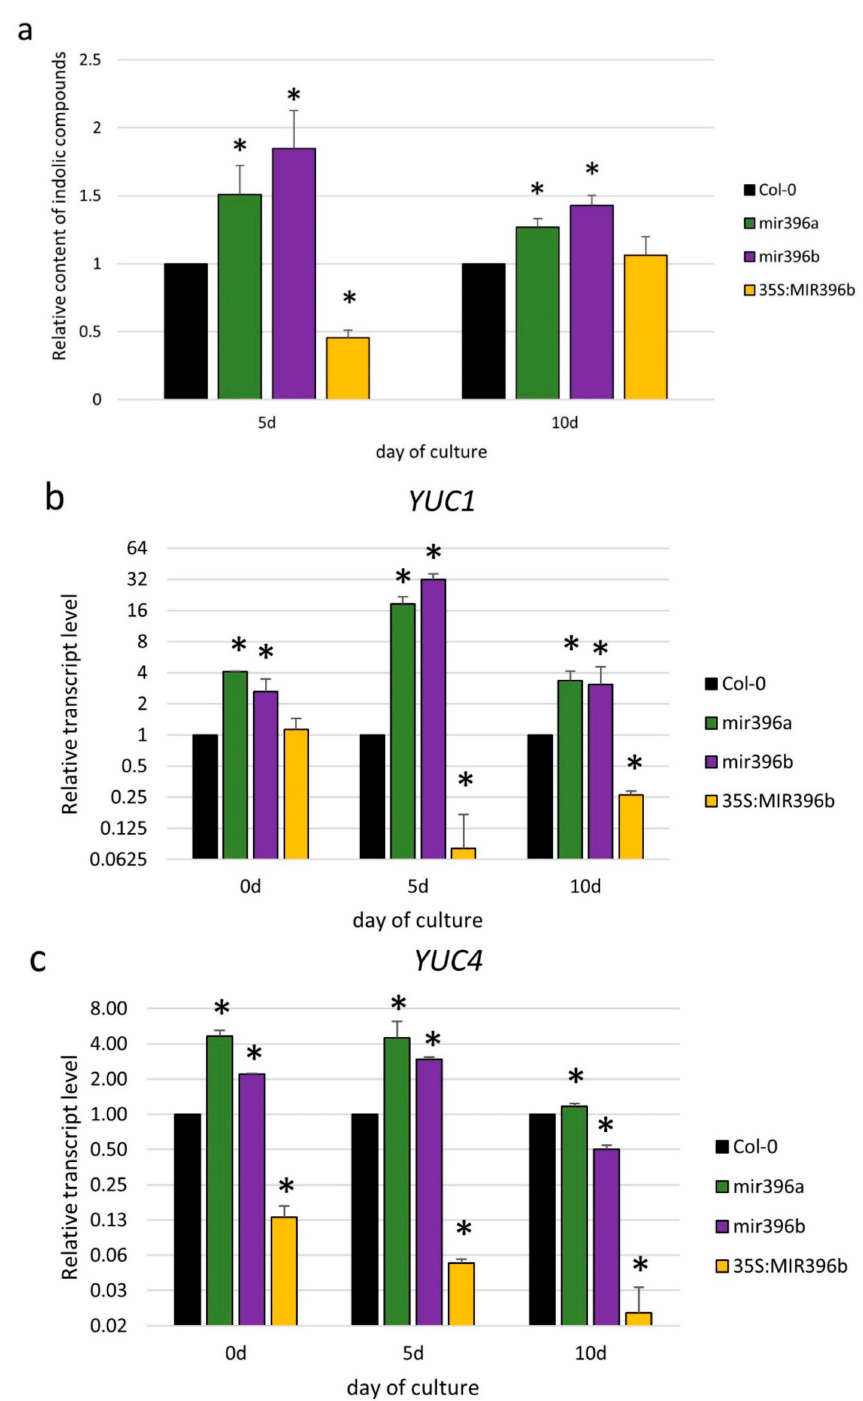
Figure 3. The auxin-related function of miR396 in an SE culture. Explants of mir396a , mir396b , 35S: MIR396b , and Col-0 (WT) were cultured on a standard SE induction medium (E5). ( a ) The relative content of the indolic compounds and the expression level of the auxin biosynthesis of the ( b ) YUC1 and ( c ) YUC4 genes were evaluated in the SE-induced explants. The relative transcript level was normalized to the internal control ( At4g27090 ) and calibrated to a Col-0 culture of the same age. The bars represent the standard deviation. Values that were significantly di ff erent from those of a WT culture of the same age are indicated with asterisks (*) ( p < 0.05; n = 3 ±